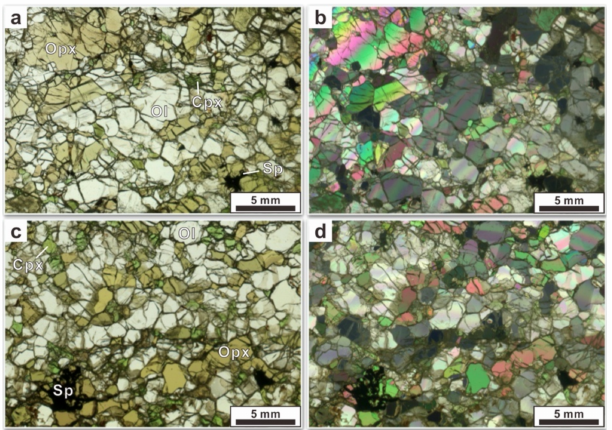
Figure 2. Optical photomicrographs of large-scale thin sections in plane-polarized light ( a , c ) and cross-polarized light ( b , d ) illustrating the typical microstructures from the Baekdusan peridotite xenoliths. ( a , b ) Coarse-granular peridotite (BD-19). ( c , d ) Fine-granular peridotite (BD-17). Ol (olivine), Opx (orthopyroxene), Cpx (clinopyroxene), and Sp